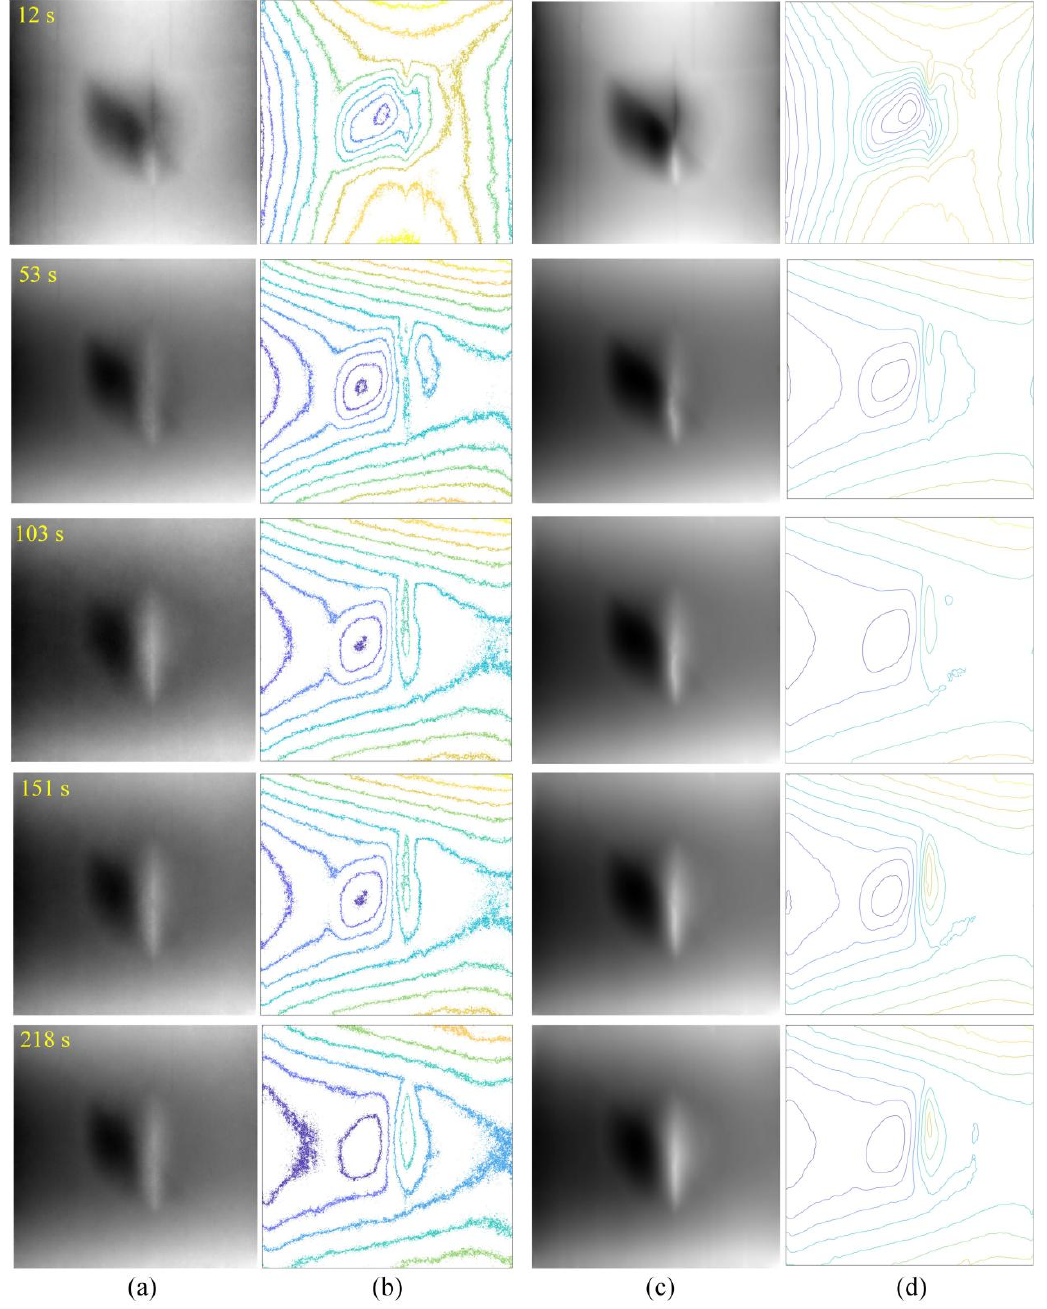
Figure 10. Phase unwrapping results using discrete cosine transform (DCT): ( a ) Unwrapping results of Figure 8b–f; ( b ) contour of ( a ); ( c ) unwrapping results of Figure 9b; ( d ) contour of (c).